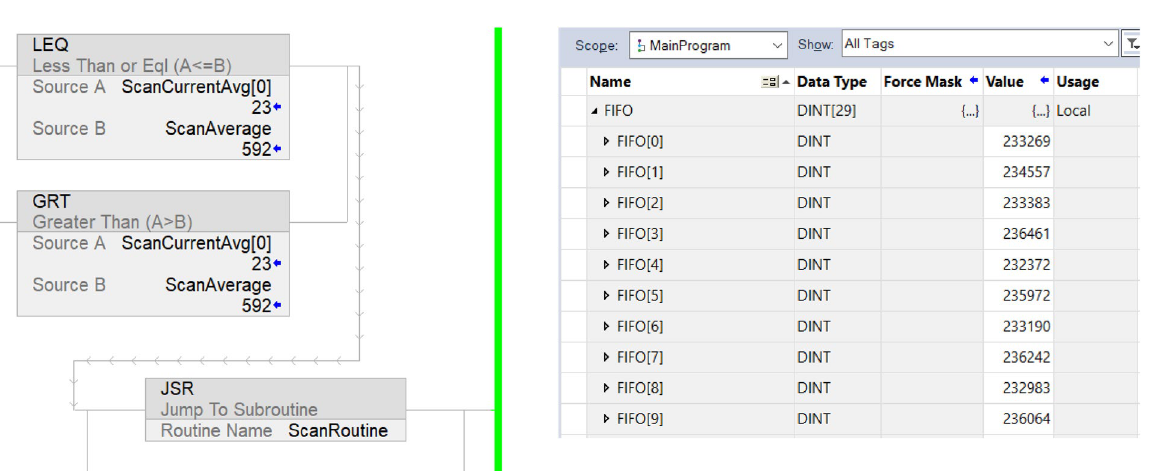
Fig. 22 Several scans time values were captured and stored